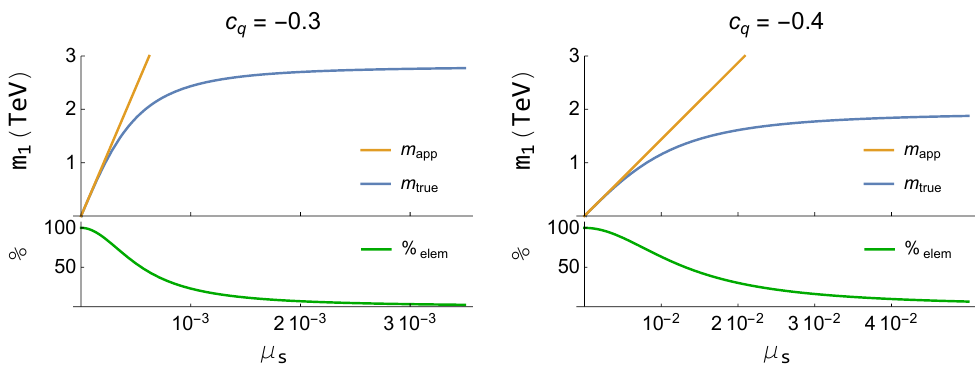
= − 0.3 (left) and , as a function of µ for c s l 1 R (cid:48) ≈ 1. 1 R